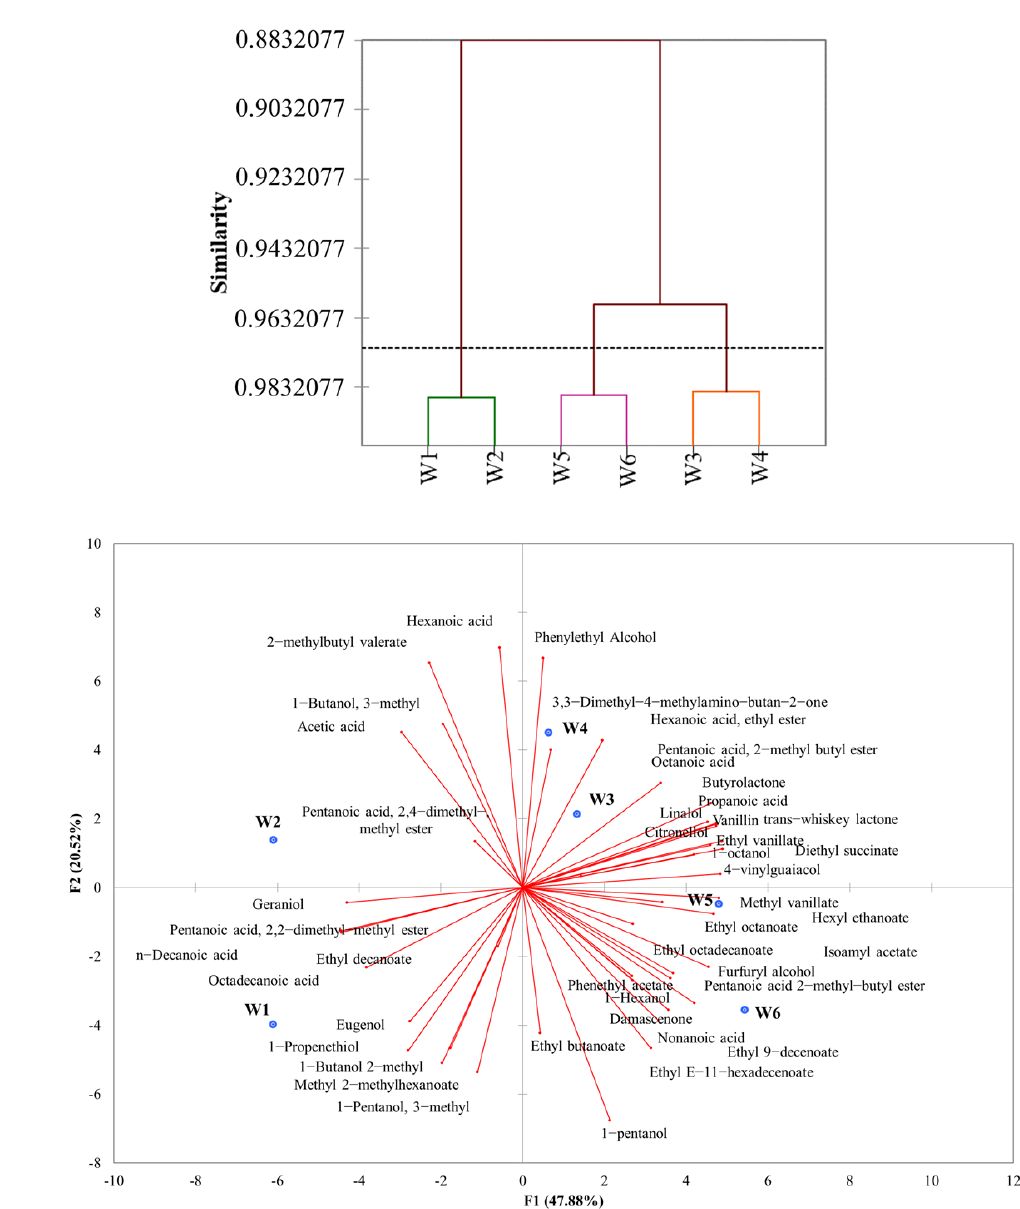
Figure 1. ( A ) Hierarchical clustering of volatile compounds in different wines. ( B ) PCA analysis encompassing the VOCs